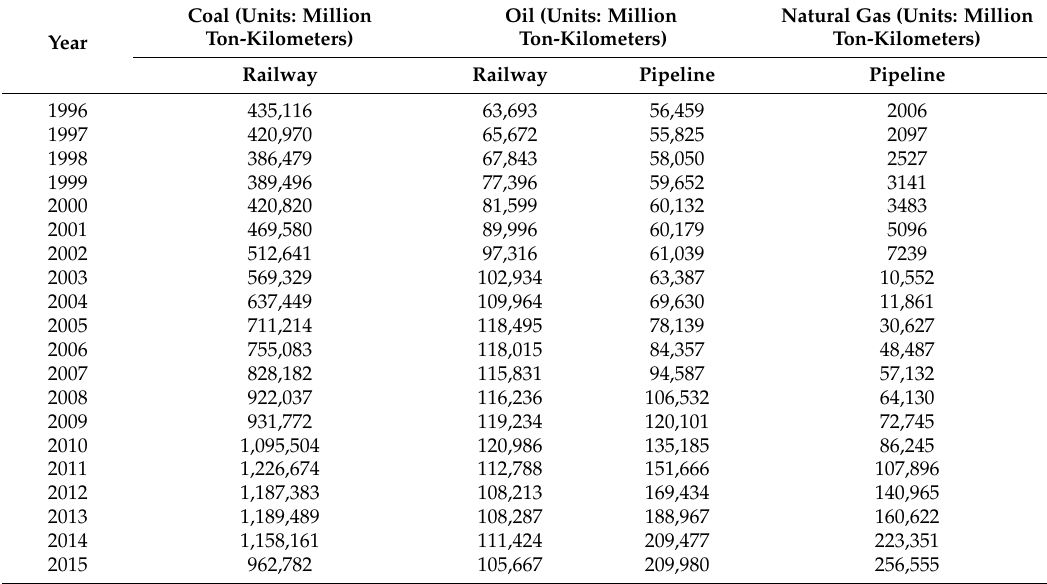
Table 4. Railway and pipeline freight traffic by fossil fuel type in